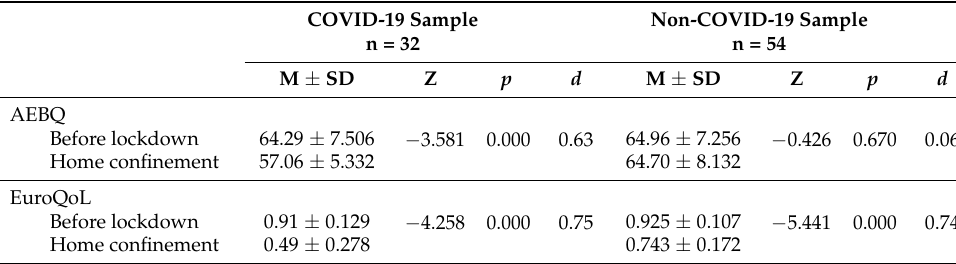
Table 2. Analysis of differences in the sample pre-pandemic period and during lockdown (n =